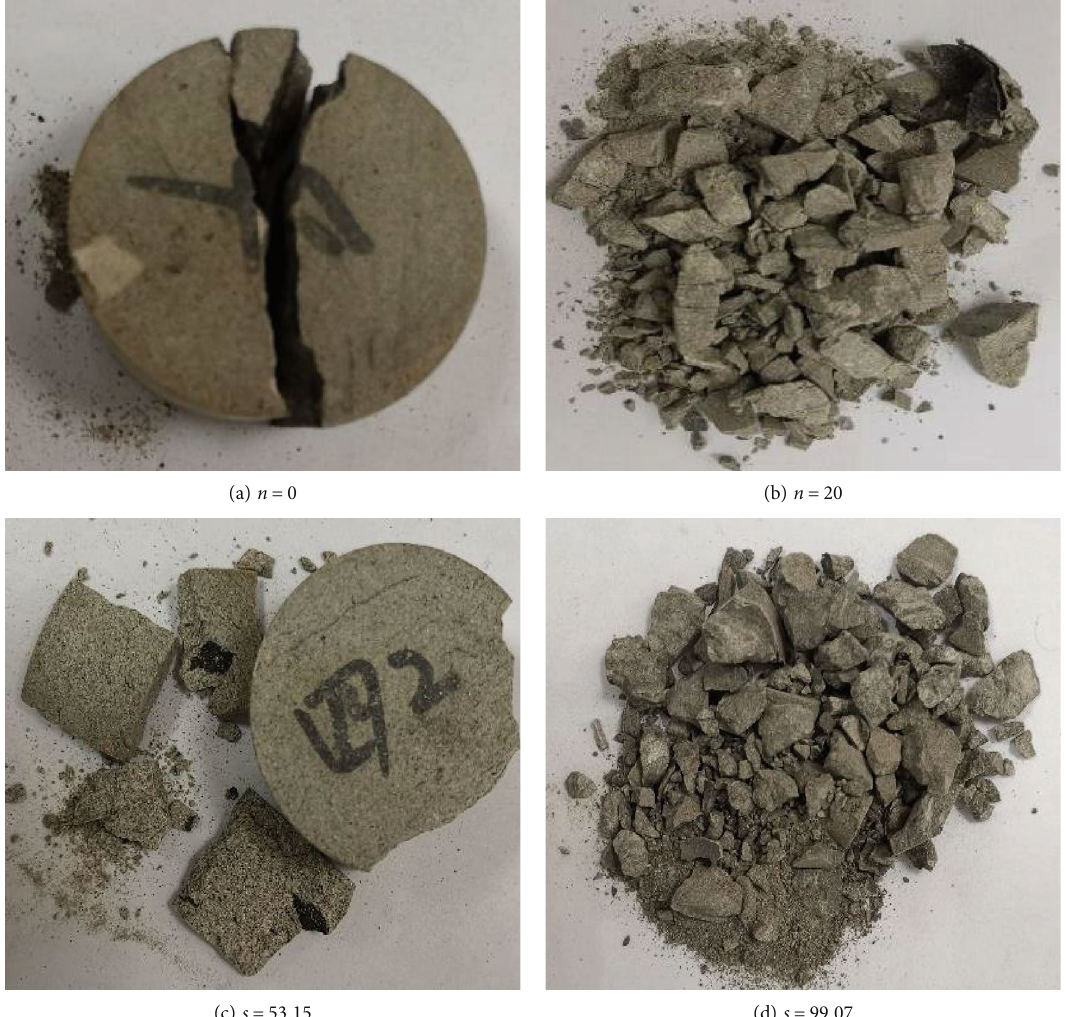
Figure 10: Failure morphology of sandstone specimens under di ff erent freeze-thaw cycles and strain